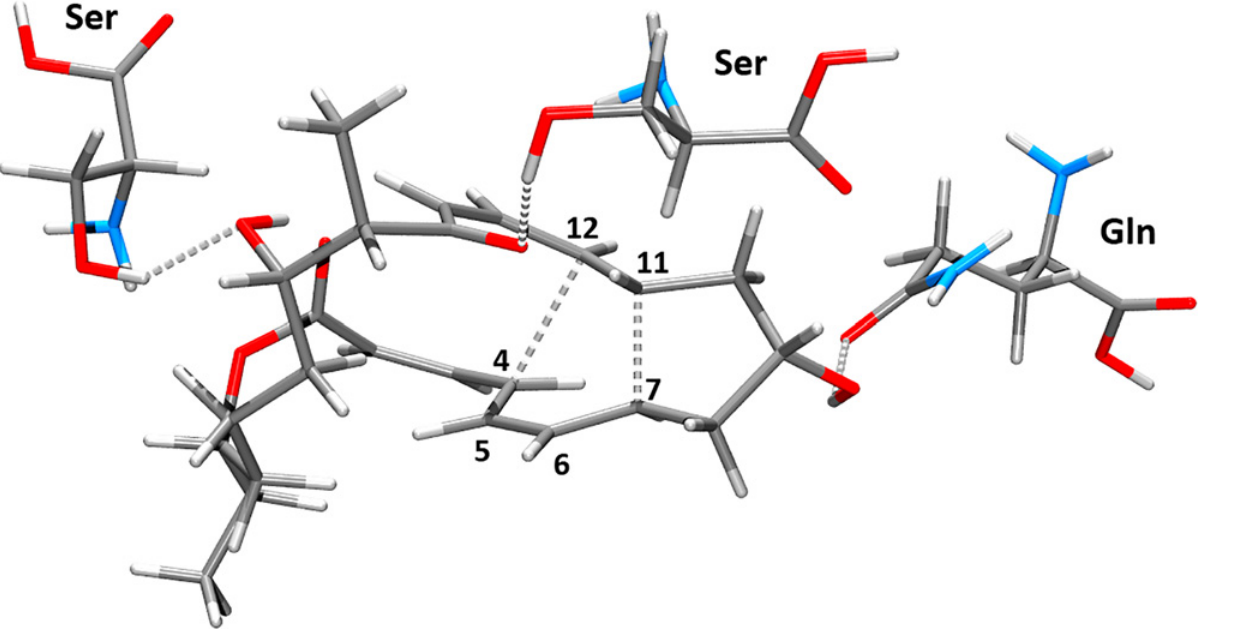
Fig 4. Optimized molecular structure of transition state